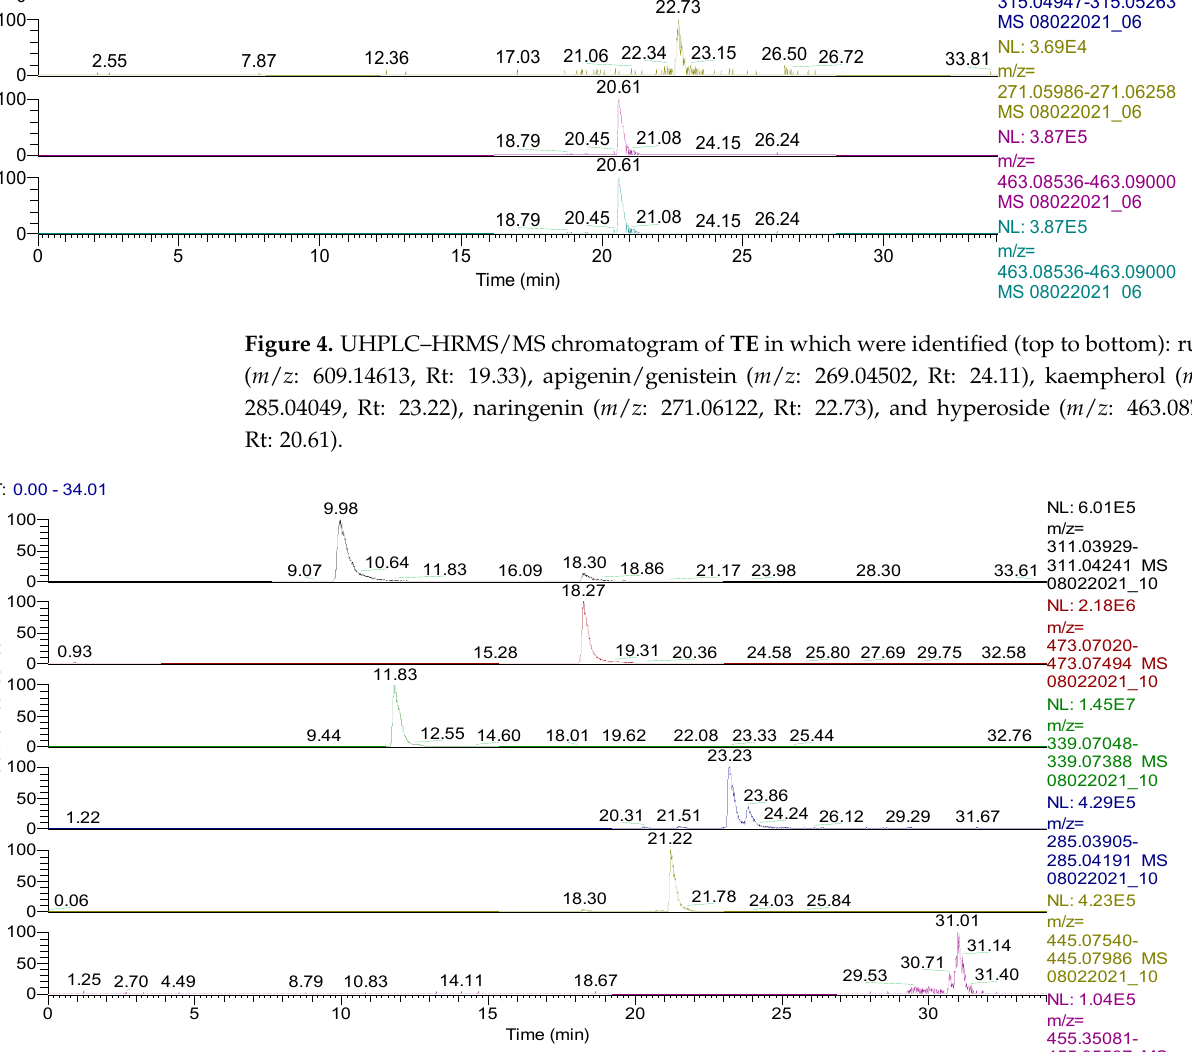
Table 5. Chemical compounds identified in CHE by UHPLC–HRMS/MS.